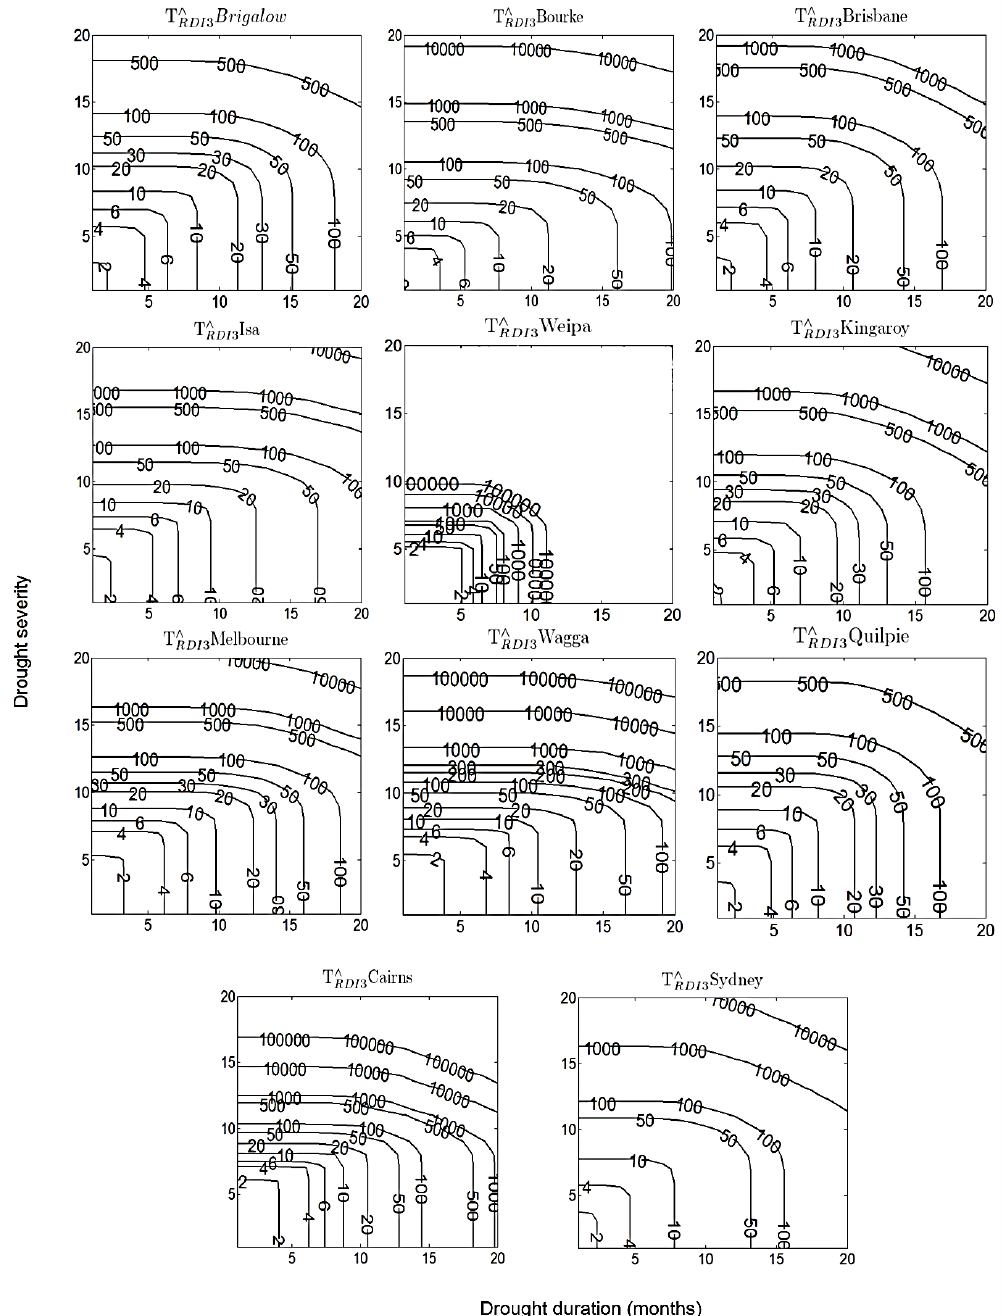
Figure D1. Recurrence intervals T ∧ (years) of drought events with any severity and duration of interest based on RDI 3 (short-term) of historical